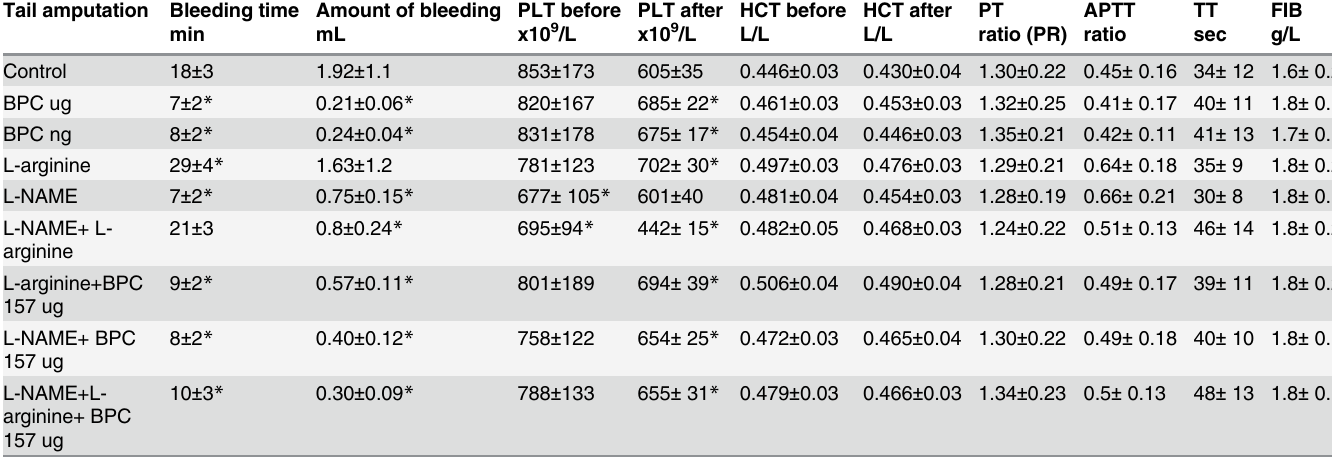
BPC 157+L-arginine-rats exhibited shorter bleeding times than corresponding controls after amputation only; amount of bleeding being even less than that of control-heparin-rats or con- trol-warfarin-rats, in addition to attenuated thrombocytopenia after warfarin administration Table 2. Normal rats. Tail amputation Bleeding time Amount of bleeding PLT before PLT after HCT before HCT